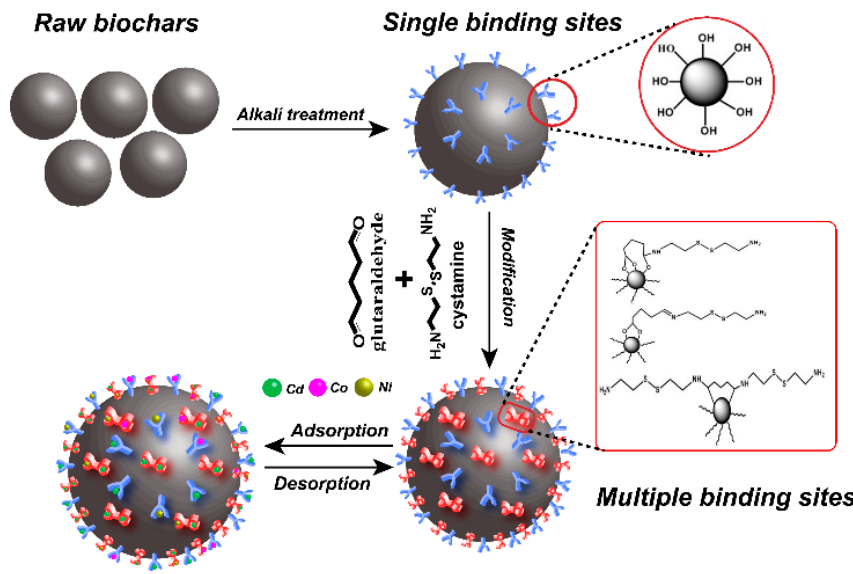
Figure 1. Schematic illustration of modification process of cystamine-modified biochars.